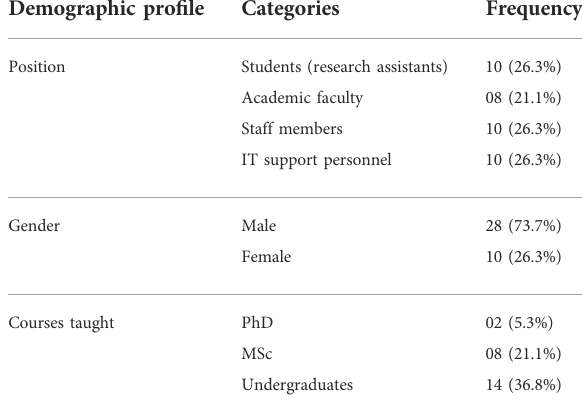
TABLE 1 Participant ’ s pro fi